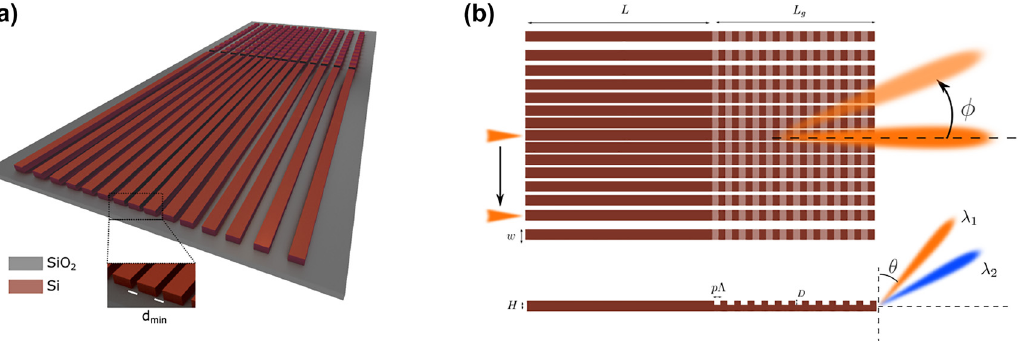
Figure 1: A schematic illustration of beam steering using the proposed waveguide array lens. (a) A scheme of the AWL that is composed of an array of waveguides with nonuniform spacing and structured waveguide tails that create an integrated grating coupler. (b) Beam steering along the azimuthal ( 𝜙 ) and polar ( 𝜃 ) angles is achieved through exciting different channels and changing the excitation wavelength,